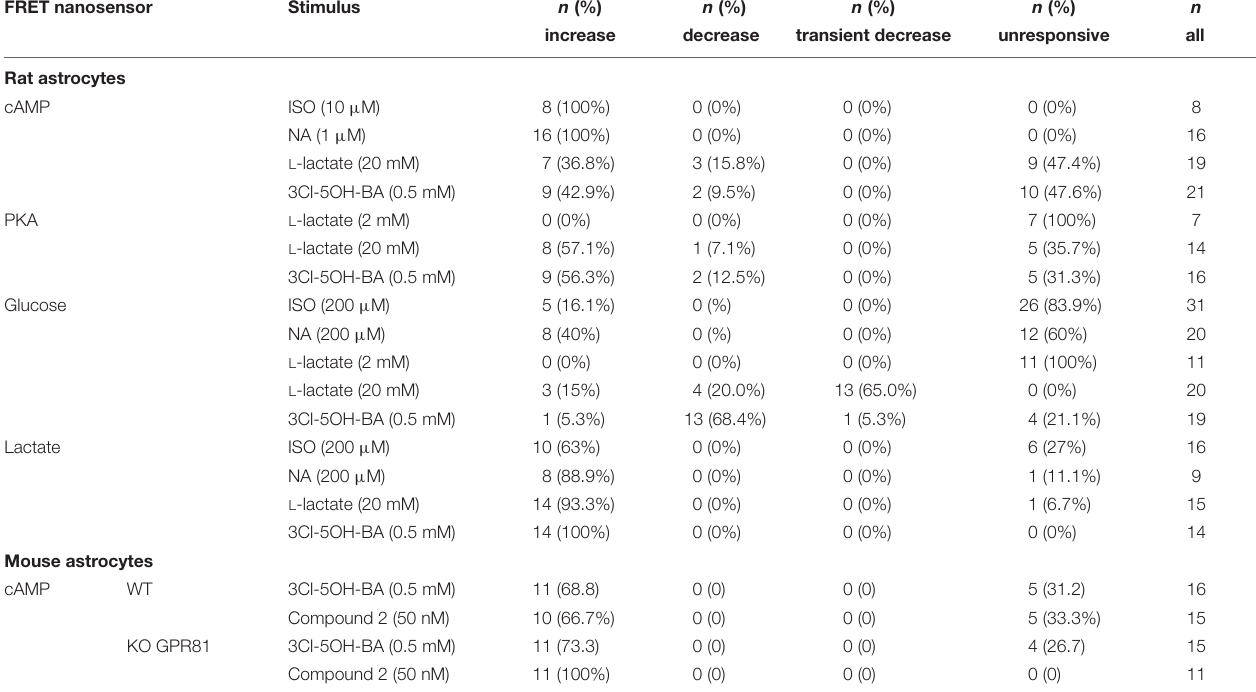
TABLE 1 | Responsiveness of astrocytes to adrenergic and L -lactate receptor activation. FRET